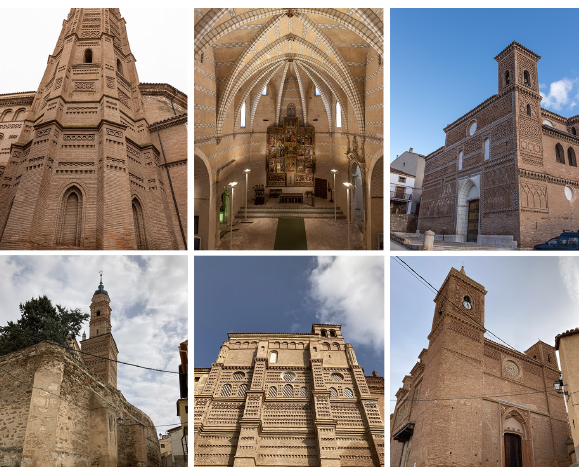
Figure 1. Some of the most representative buildings of the Aragonese Mud´ejar